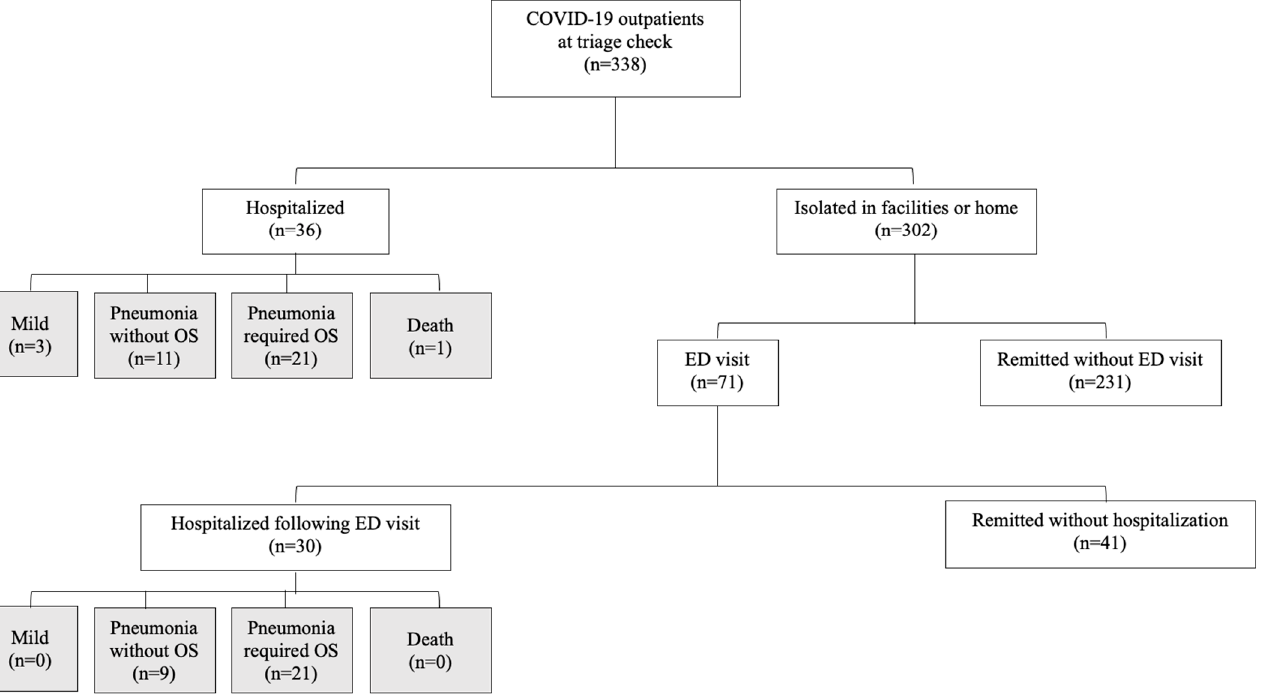
Figure 1. Flowchart demonstrating the numbers of patients with COVID-19 who visited the outpatient triage, who were immediately hospitalized at triage, who visited the ED during isolation, and who were hospitalized upon their ED visit during isolation (white-filled squares). Hospitalized patients were followed up, and their outcomes were recorded (gray-filled squares). Abbreviations: OS, oxygen supplementation; ED, emergency